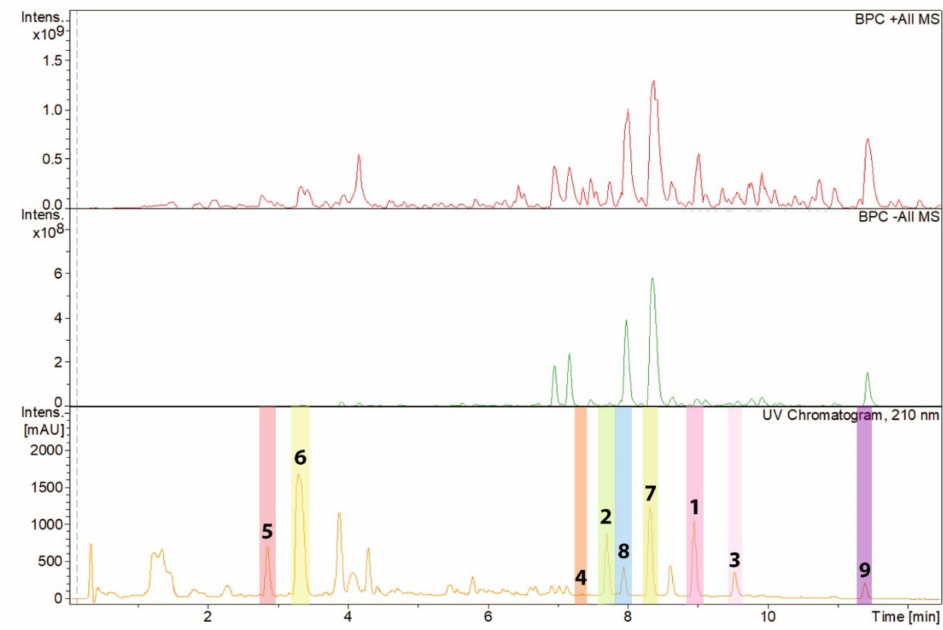
Figure 2. High-performance liquid chromatography (HPLC) chromatogram (210 nm) of the ethyl acetate (EtOAc) extract from Pseudorhypophila mangenotii with peaks of the compounds isolated referring to the molecules depicted in Figure 3. The peaks representing compounds 1 – 9 have been highlighted with different colors.